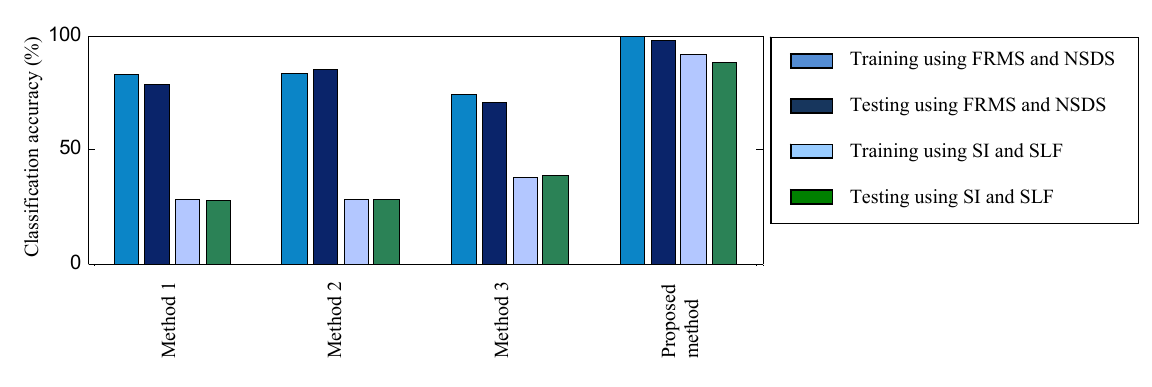
Figure 9. Accuracy comparison between Methods 1~3 and the proposed method for Case